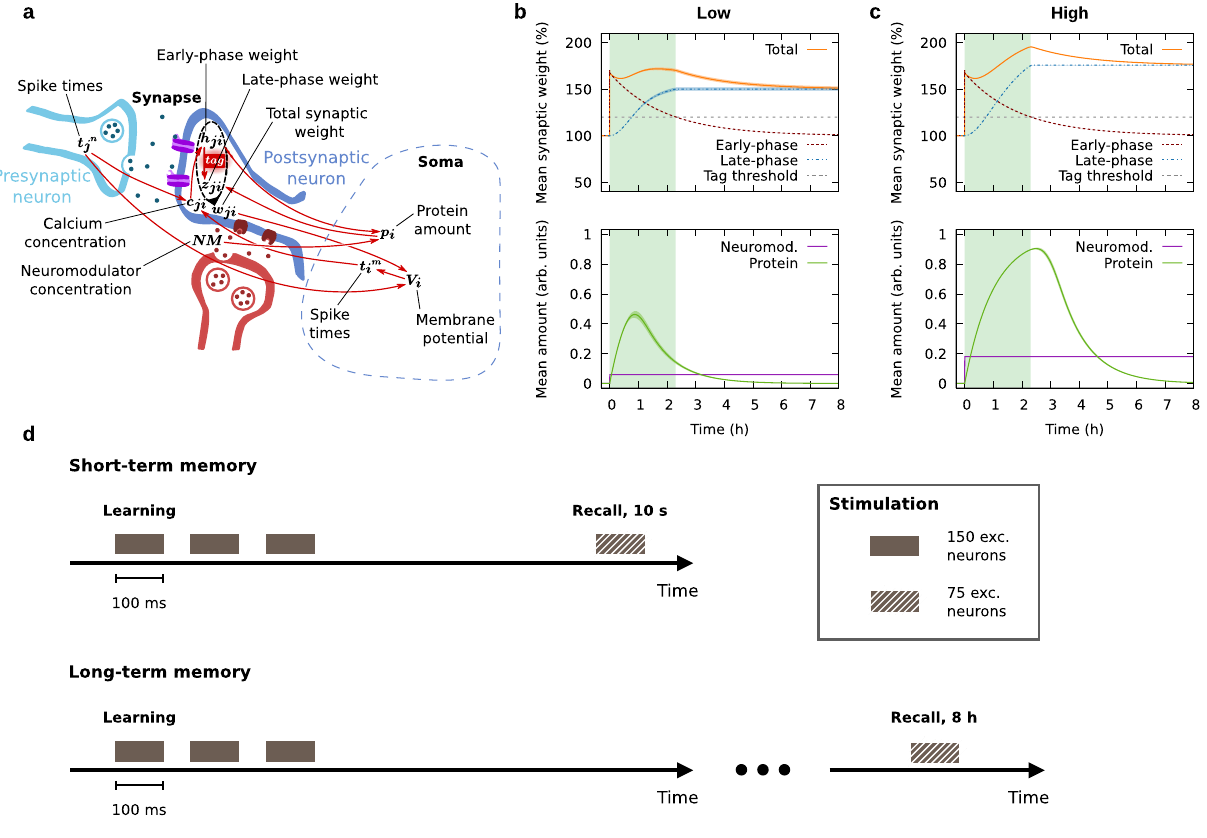
Figure 1. Model and stimulation protocols. ( a ) Synaptic model integrating calcium-based early-phase plasticity and STC-based late-phase plasticity, depending on neuromodulation. ( b ) Mean synaptic weight, neuromodulator, and protein amount within the cell assembly core over time in the case of a low level of neuromodulation ( NM = 0.06 ). ( c ) Mean synaptic weight, neuromodulator, and protein amount within the cell assembly core over time in the case of a high level of neuromodulation ( NM = 0.18 ). The green rectangular shading indicates the average lifetime of the synaptic tag. Error bands indicate the standard deviation over 50 trials. ( d ) Stimulation protocol to learn and recall a memory representation. Recall stimulation is applied either 10 s or 8 h after learning, corresponding to short-term and long-term memory,